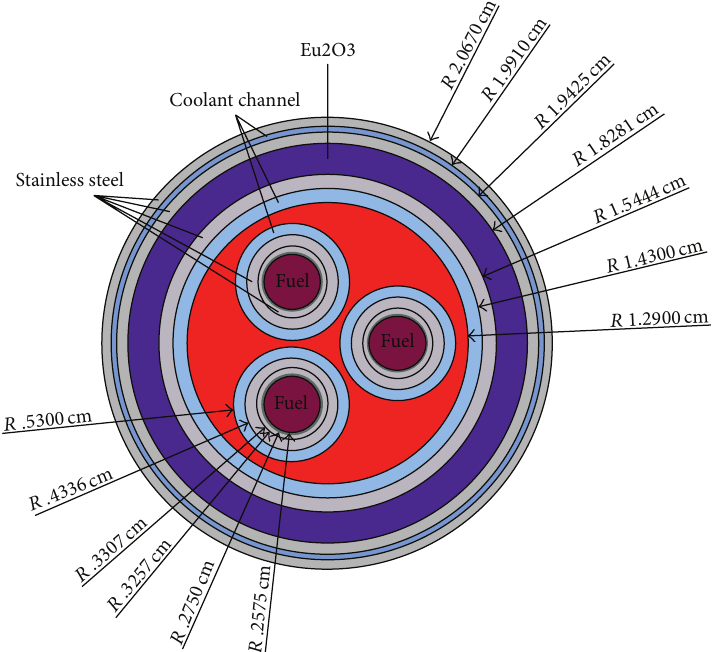
Figure 25: Tri-pin fast flux shielded irradiation design at HFIR (ORNL) [25].